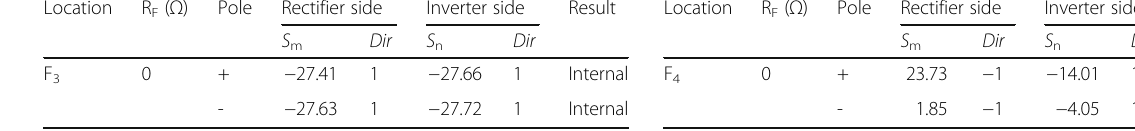
Table 3 Simulation results for a fault at F 3